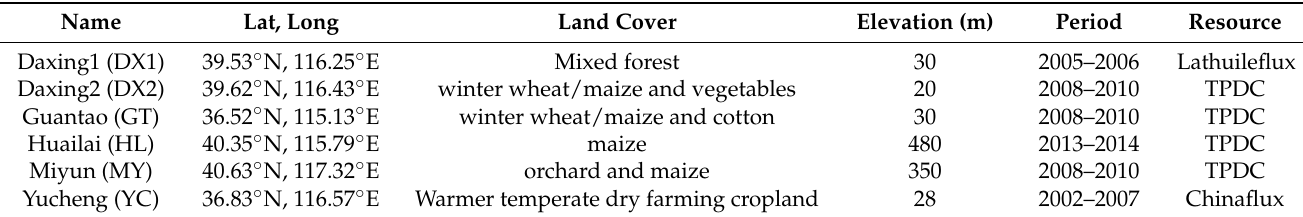
Table 1. Information of the Six Flux Tower Sites Used in This Study.